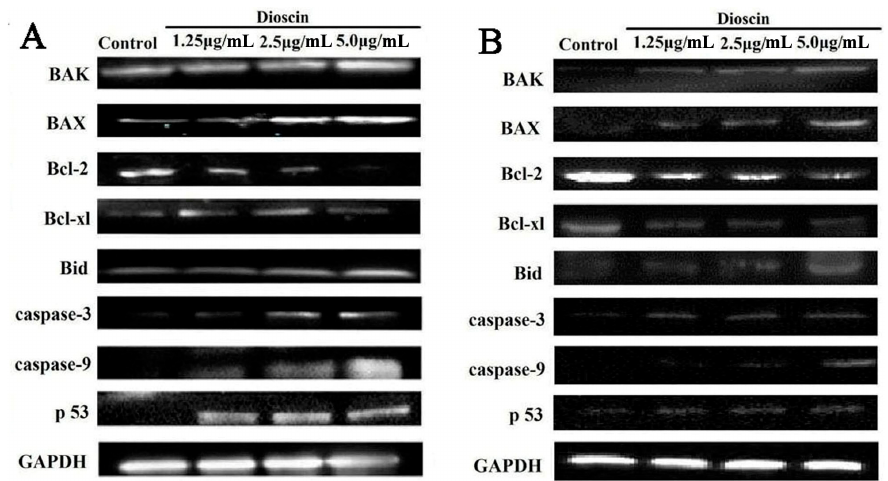
Figure 9. Dioscin adjusted cell apoptosis signaling pathway. ( A ) Effects of dioscin on the protein levels of Bcl-2, Bcl-xl, Bax, Bak, Bid, p53, caspase-3 and caspase-9 in HeLa cell; ( B ) Effects of dioscin on the protein levels of Bcl-2, Bcl-xl, Bax, Bak, Bid, p53, caspase-3 and caspase-9 in SiHa cell.